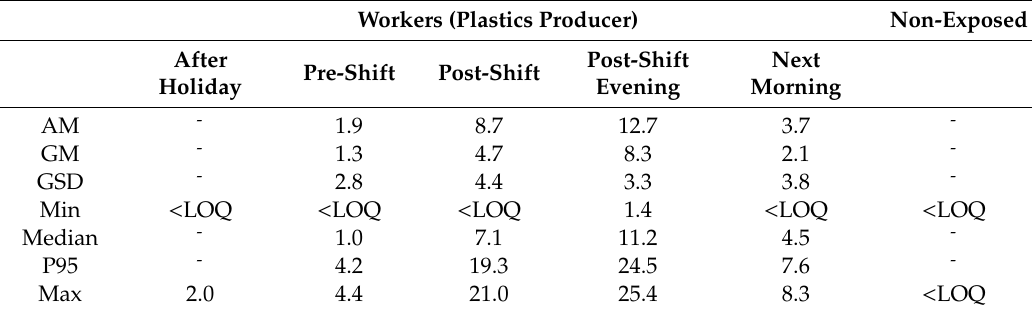
Table 2. Total urinary OH-MPHP concentrations of workers in plastics producing company ( n = 5) by sampling time. First-morning-void concentrations of occupationally non-exposed control population ( n = 60) are provided for comparison [9]. Concentrations ( µ g / L) were normalized to a specific gravity of 1.021. Workers (Plastics Producer) Non-Exposed After Post-Shift Next Pre-Shift Post-Shift Holiday Evening Morning AM - 1.9 8.7 12.7 3.7 - 1.3 - 1.4 < LOQ < LOQ Median 1.0 7.1 11.2 4.5 <